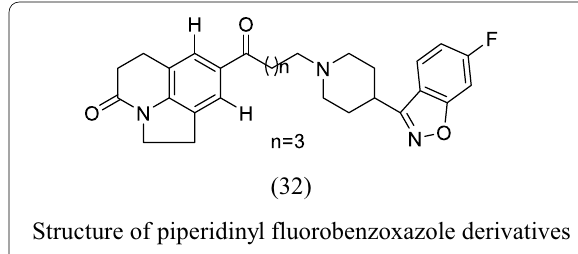
Fig. 37 Structure of piperidine diamine derivatives